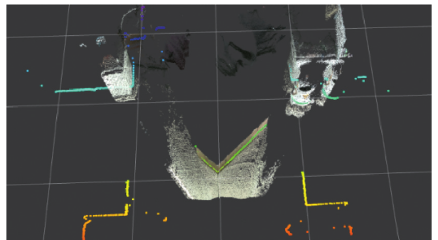
Figure 3: Calibration results between Kinect and the laser range